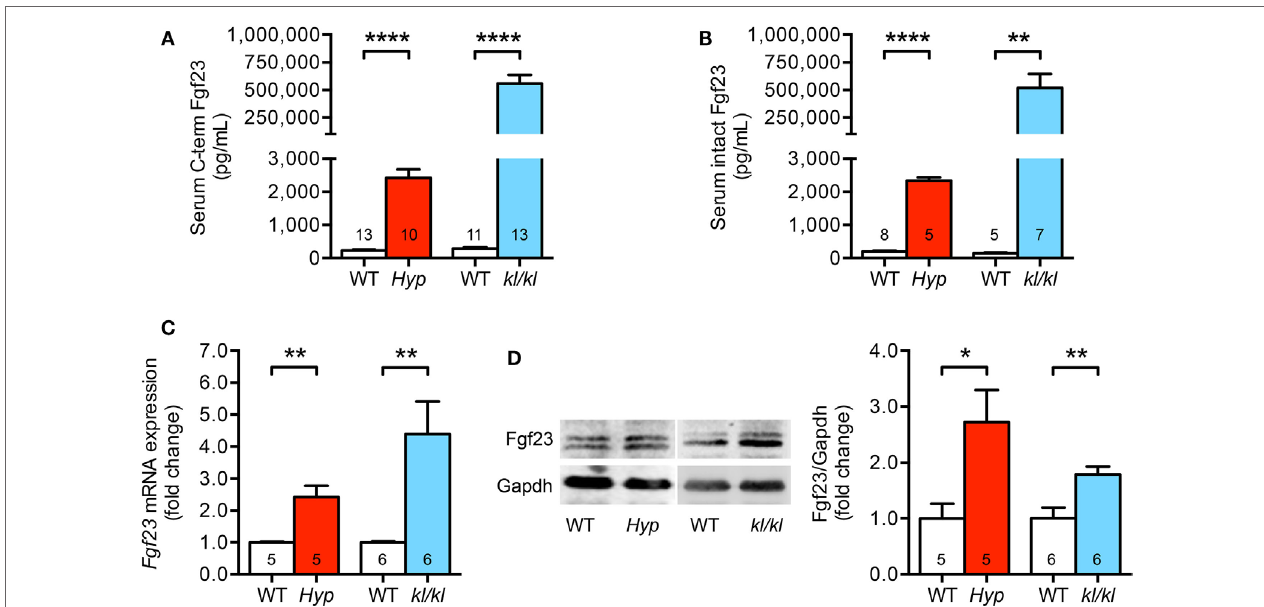
FigUre 1 | Serum Fgf23 levels and cardiac Fgf23 expression are elevated in Hyp and kl/kl mice. (a) Increased serum C-term Fgf23 levels in both Hyp and kl/kl mice as compared to respective wild-type mice. (b) Elevation of intact Fgf23 concentrations in the serum of Hyp and kl/kl mice than in respective control mice. (c) Fgf23 mRNA levels are increased in cardiac tissue of both mouse lines demonstrated by quantitative real-time PCR after normalization to Gapdh . (D) Representative immunoblot and respective quantification show the elevation of Fgf23 protein levels in total heart lysates of Hyp and kl/kl animals (Gapdh served as loading control). Values are presented as mean ± SEM; numbers in each bar graph represent the n- values used for the respective measurement; * P < 0.05, ** P < 0.01, **** P <